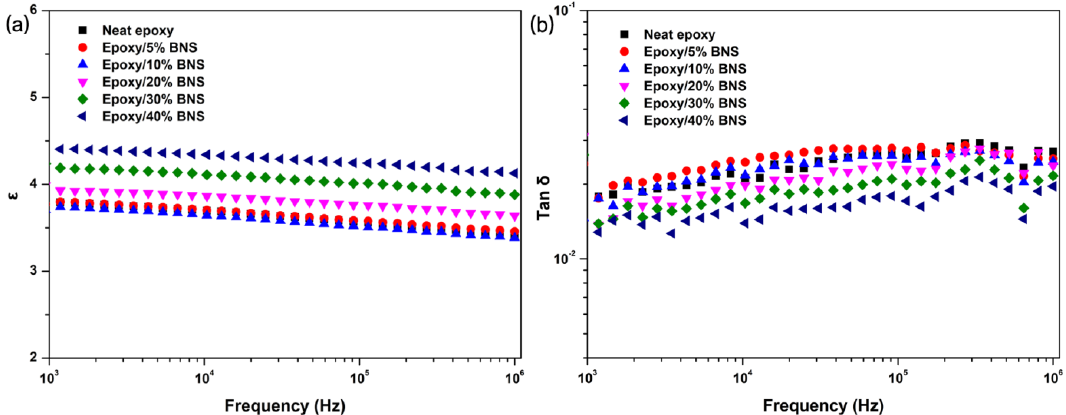
Figure 6. ( a ) Dielectric constant and ( b ) dielectric loss tangent as a function of frequency for the epoxy/BNS composites.